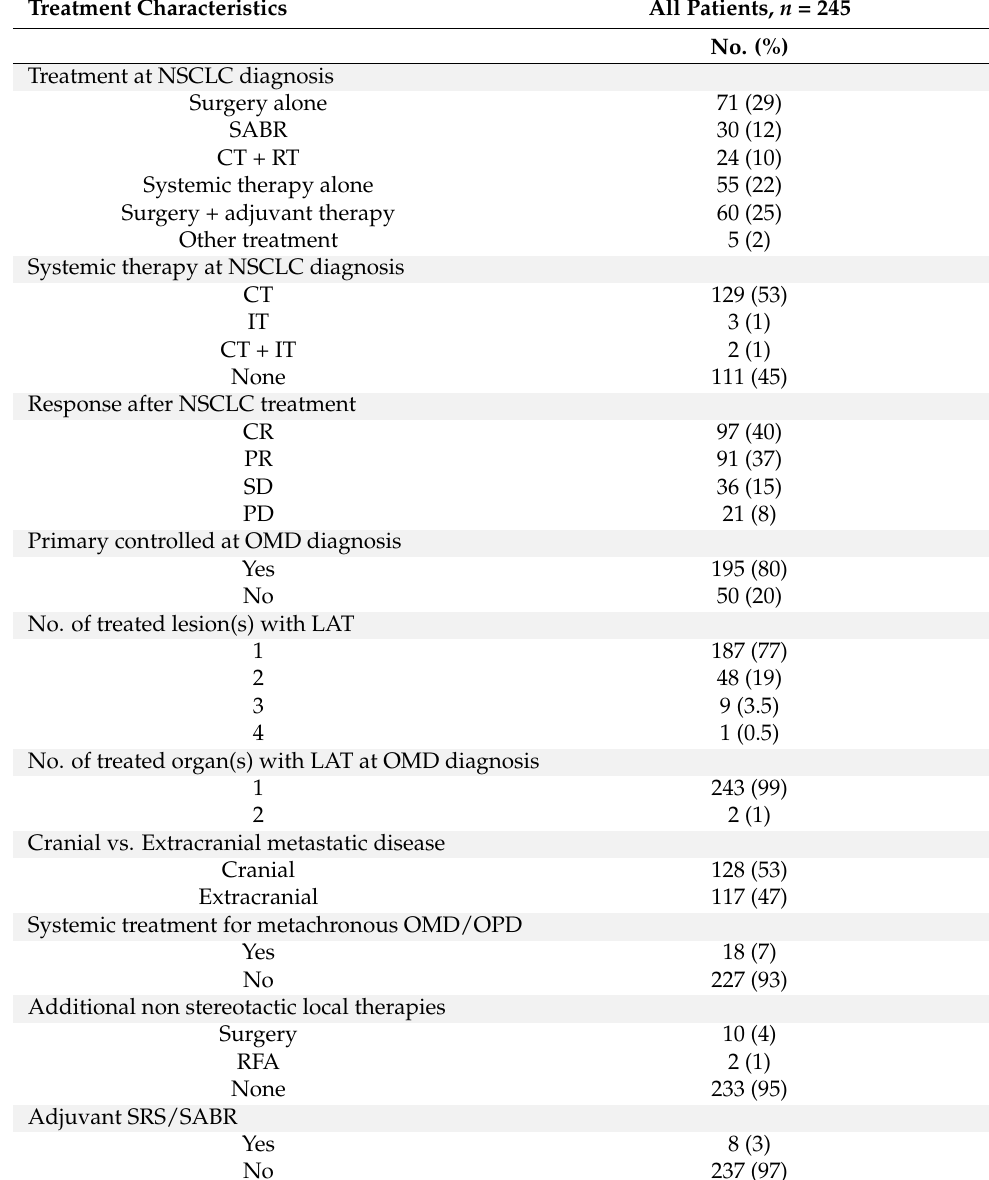
Table 2. Treatment